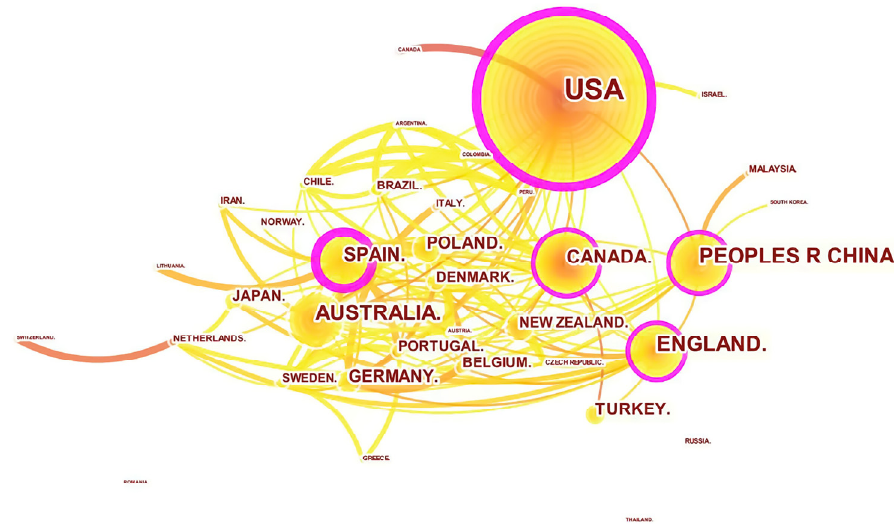
Figure 6. Collaboration network of the country.